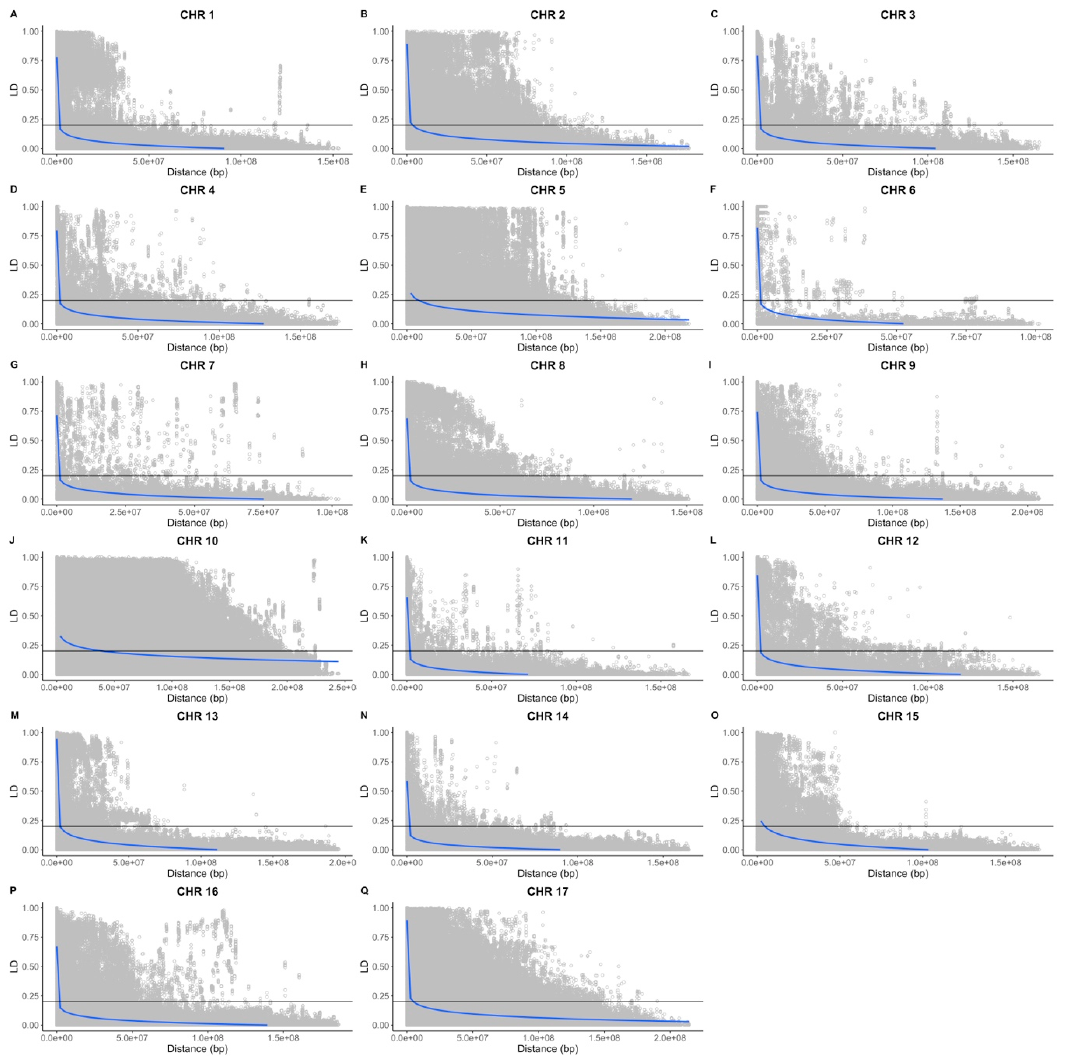
Figure 5. Linkage disequilibrium (r 2 ) vs. physical distance (bp) for the full panel of accessions. A cut-off line was plotted at r 2 = 0.2. The blue line represents the y ~log(x) function. ( A – Q ) Sunflower chromosomes 1 to 17. CHR = chromosome